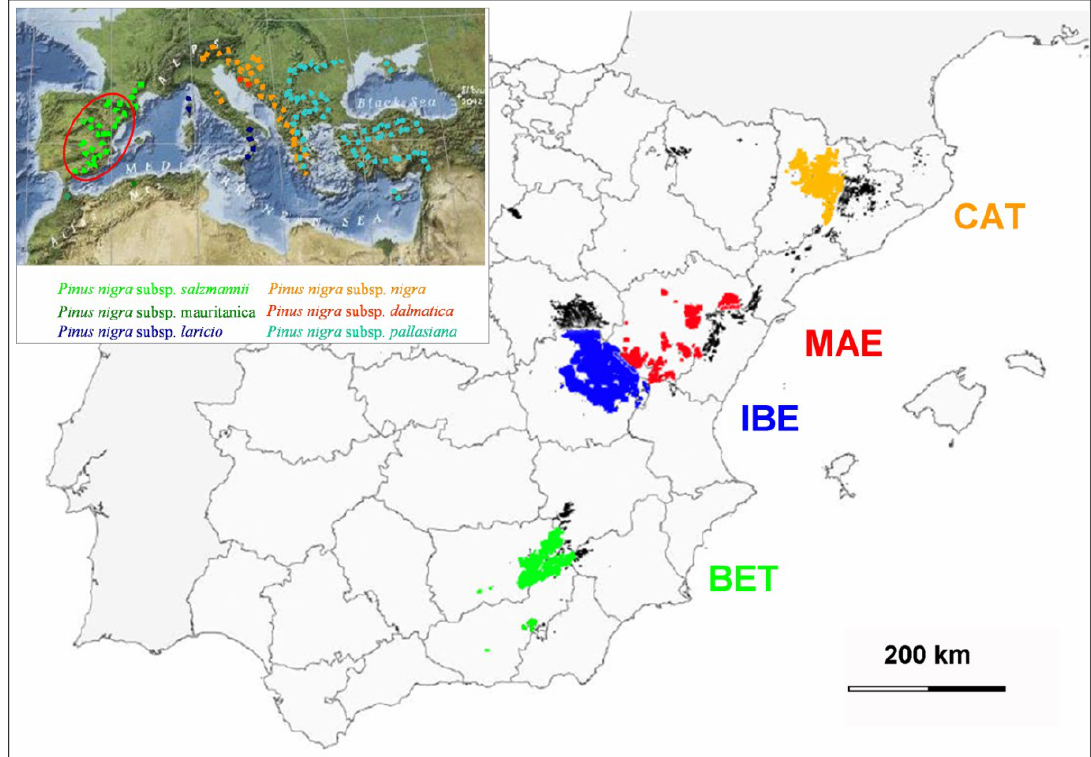
Figure 1. Geographical distribution of Pinus nigra ssp. salzmannii in Spain with indication of the four study regions: Prepirineo Catalán (CAT) in yellow, Alto Maestrazago-Montes Universales (MAE) in red, Sistema Ibérico Meridional (IBE) in blue, and Cordilleras Béticas (BET) in green. The inset indicates the distribution area of Pinus nigra sensu lato